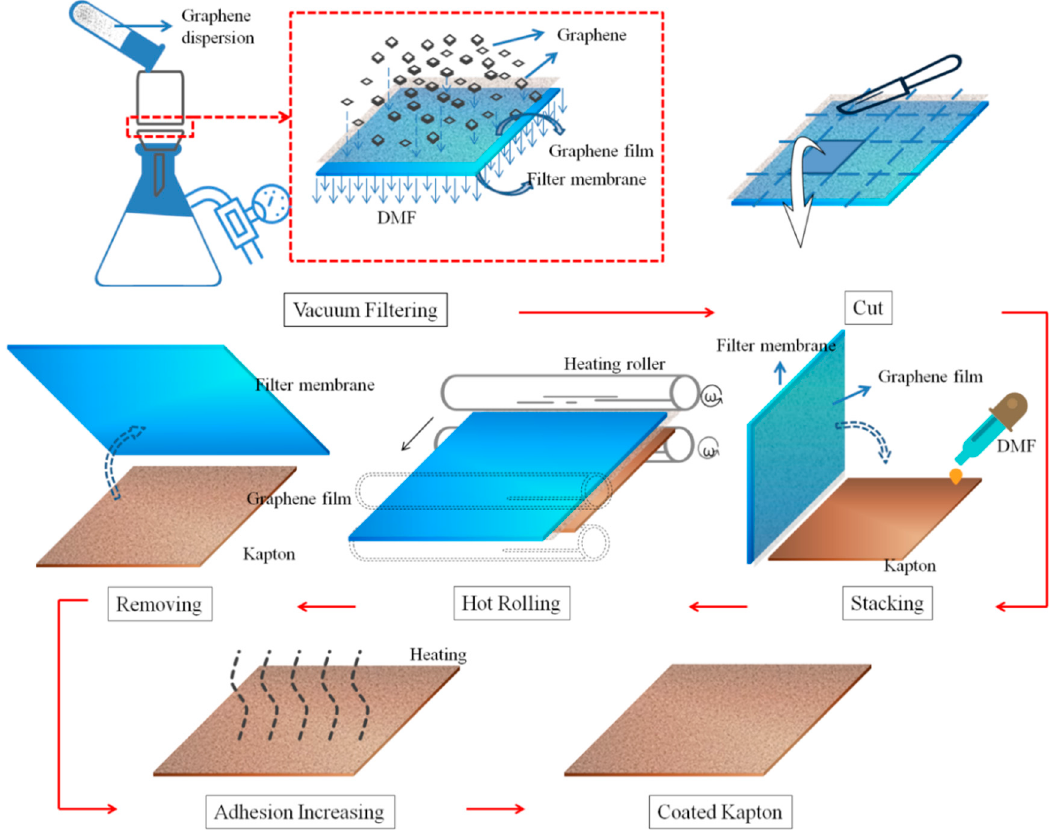
Figure 2. The preparation of graphene coating on Kapton. Coatings 2020 , 10 , x FOR PEER REVIEW